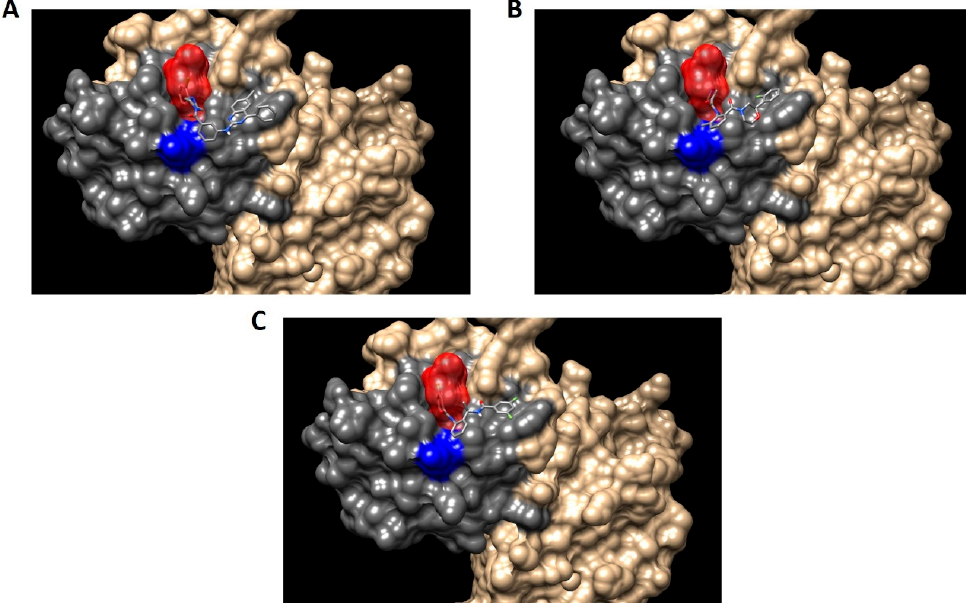
Figure 9. Spatial arrangement of the resulting compounds in the hDKC1 3D structure model. hDKC1 is colored in beige Residue K314 is indicated in blue, the PUA domain is colored in dark gray and Pocket 13 is highlighted in red. ( A ) E1; ( B ) E5; ( C ) E8.